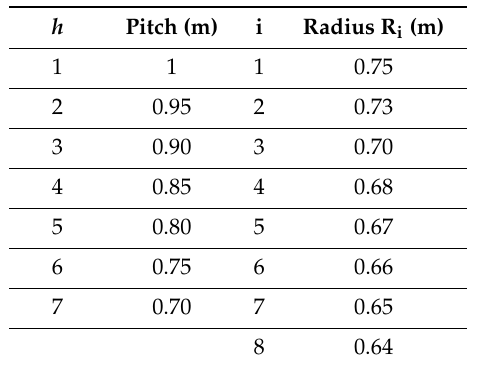
Table 3. Pitches and radius helicoid values determined.